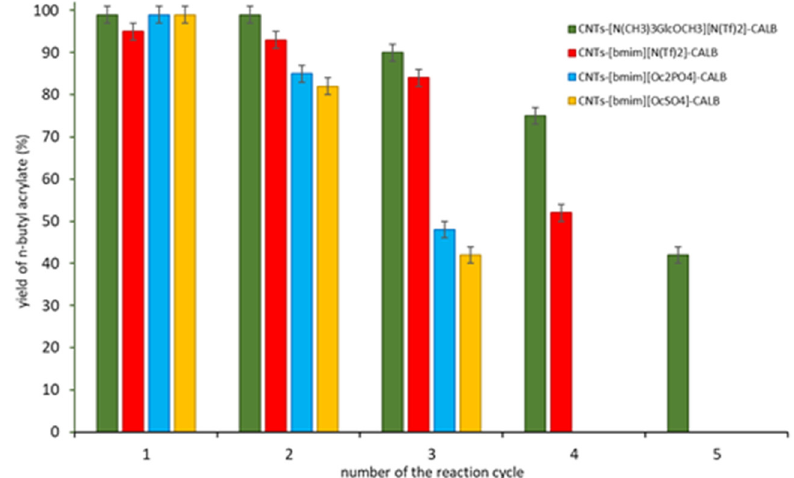
Figure 3. The recycle of CNTs-IL-CALB. Preparation of CNTs-IL-CALB conditions : 1st step: CNTs 1.0 g, IL 0.5 g, acetonitrile 25 mL; 2nd step: CNTs-IL 1.0 g, 7.5 g CALB, water 30 mL; Reaction conditions: AA